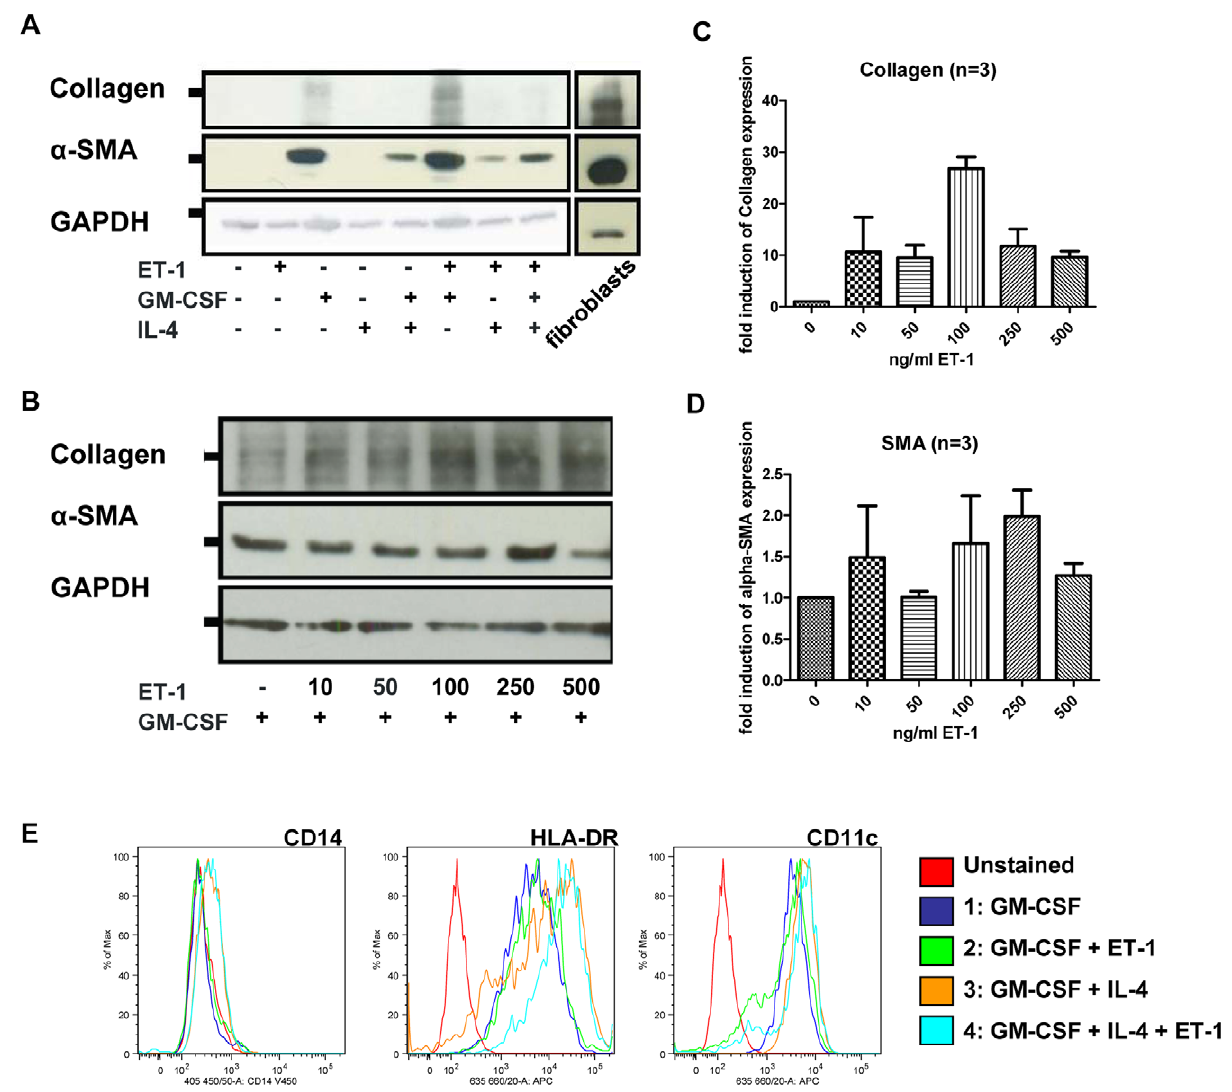
Figure 1. Healthy monocytes can differentiate into a -SMA and collagen expressing cells upon GM-CSF stimulation. A) CD14 + monocytes from healthy donors were cultured for 14 days with GM-CSF, IL-4 or ET-1. Western blot analysis showed expression of type-1 collagen and a -SMA under distinct conditions. Fibroblasts were used as a positive control, GAPDH was used as loading control. B) Monocytes were treated with GM-CSF and 0–500 ng/ml of ET-1 over 14 days. Western Blot analysis for type-1 collagen and a -SMA was conducted. GAPDH was used as loading control. C) and D) Quantification of the western blots from 3 independent experiments are shown. E) Expression of CD14, HLA-DR and CD11c was assessed by flow